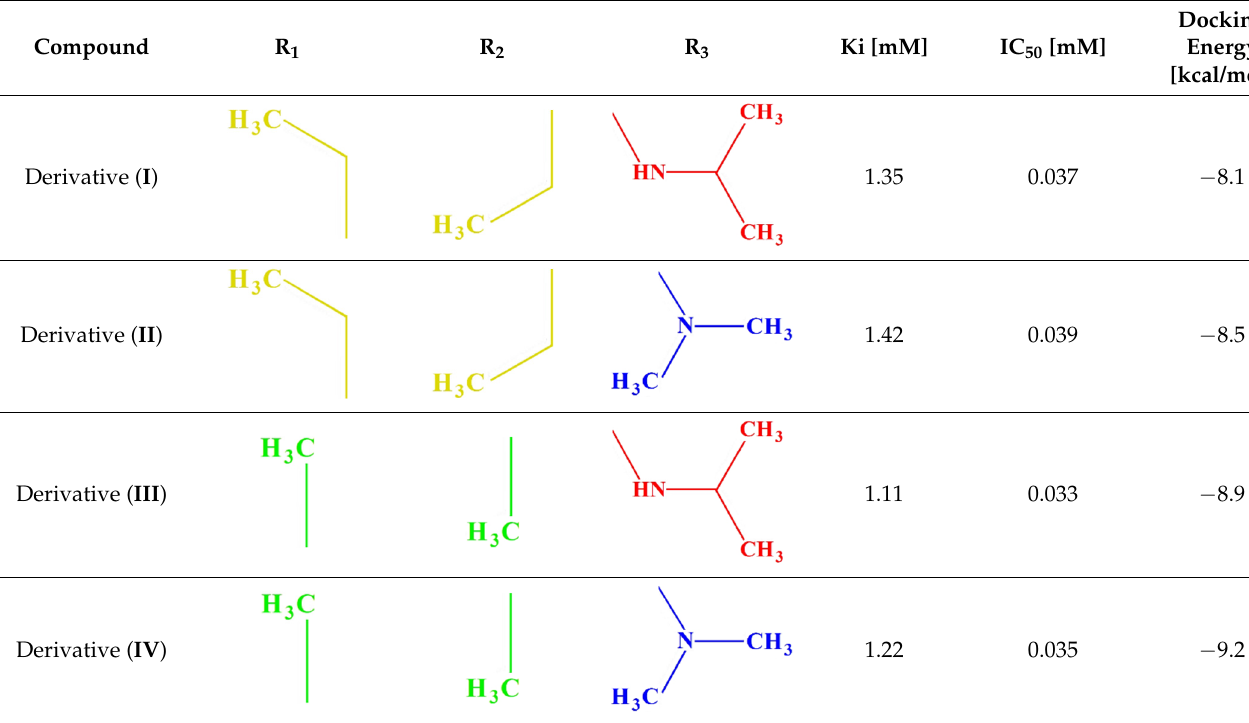
Table 3. Effect of the type of substituents occurring in the main structure of aminoalkanol derivatives